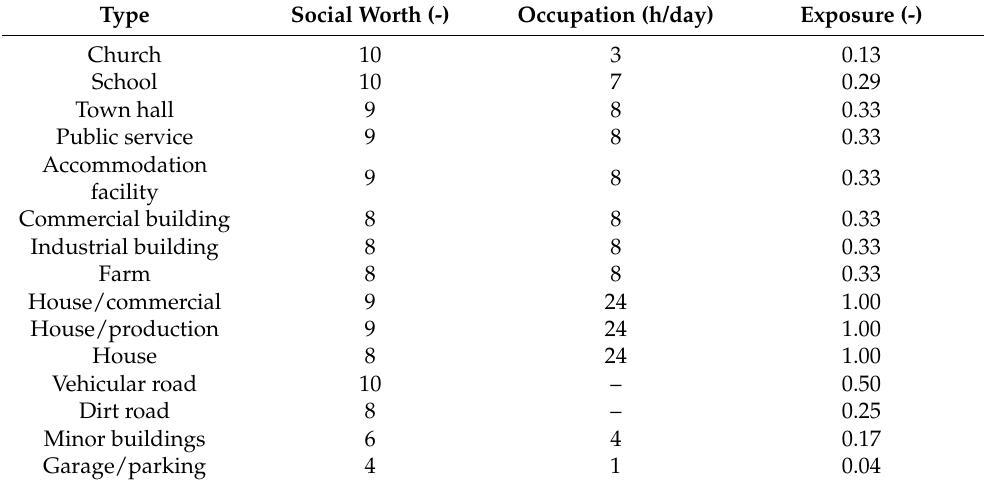
Table 5. Assets for social